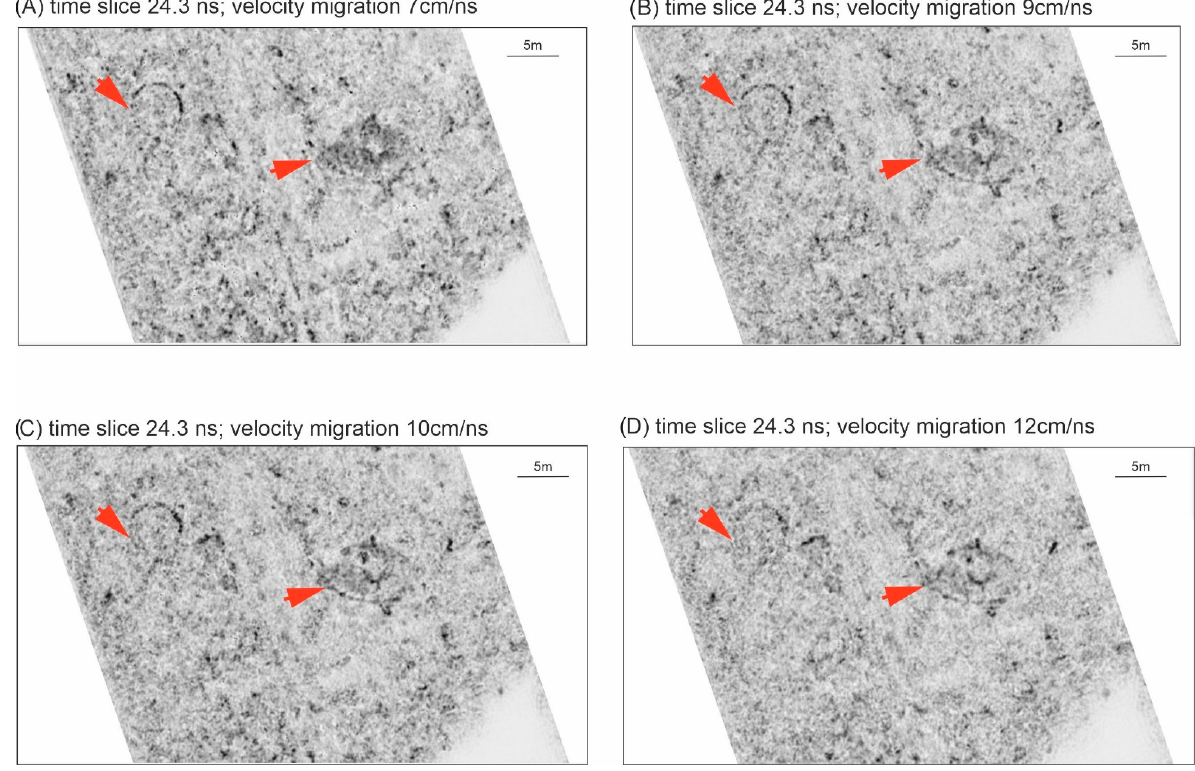
Figure 3. Comparison of time migration computed using different constant velocity values (( A ): 7 cm/ns; ( B ): 9 cm/ns; ( C ): 10 cm/ns; ( D ): 12 cm/ns) on a portion of the 3-D volume (location in Figure 2). Red arrows point to EM features with specific circular and semi-circular shapes.